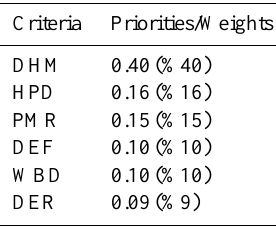
Table 4. Criteria priority/weight